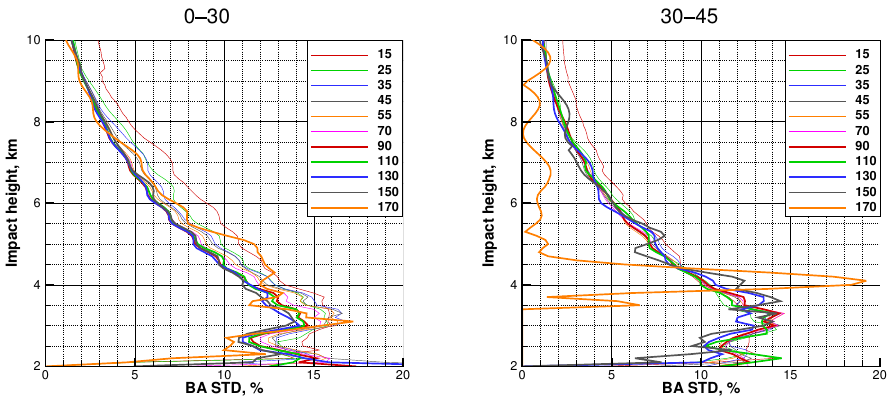
Figure 5. Similar to Figure 2. COSMIC-2, systematic difference. COSMIC-2 profiles are limited by ± 45 degrees latitudes.